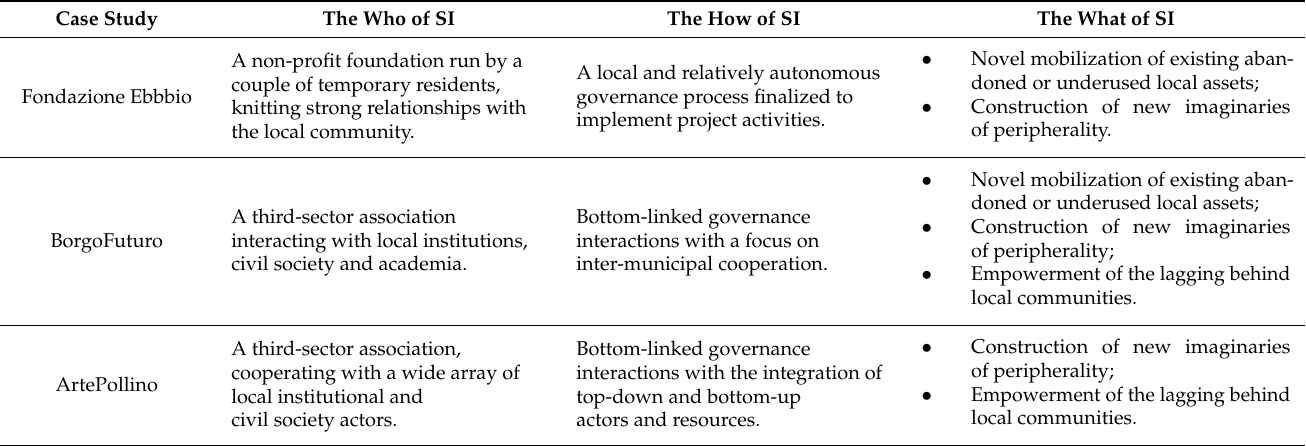
Table 3. Summary of the three dimensions investigated in the three case studies. Source: elaboration by the